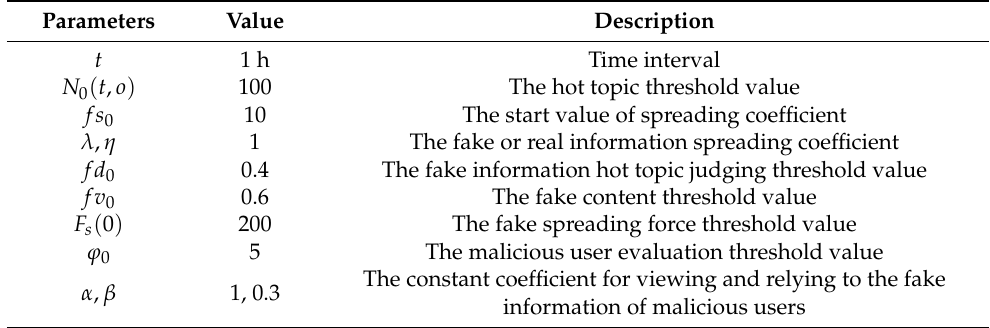
Table 1. Parameter configuration of the experiment.